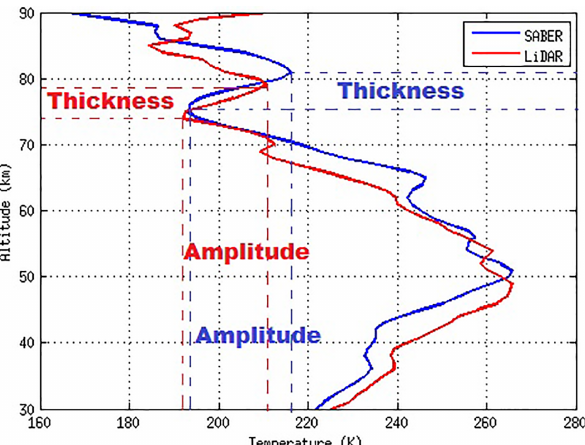
Figure 1. Vertical temperature profile obtained from lidar (red line) and SABER (blue line) measurements over Réunion on 13 June 2005. The thickness (lidar = 5.2km; SABER = 6.1km) and the amplitude (lidar = 18.5K; SABER = 23.3K) of the MIL are in- dicated by the dashed